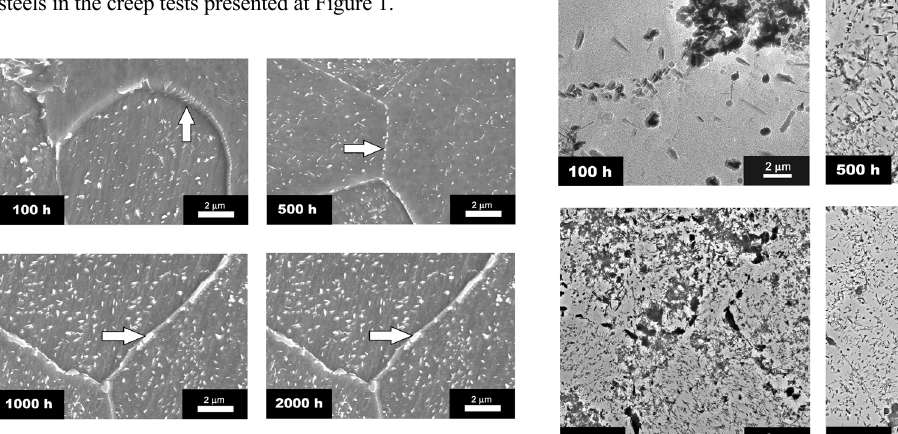
Figure 4: Ferritic-pearlitic steel scanning electron micrographs at 600°C and 100, 500, 1000 and 2000 h of aging. The arrows indicate the carbides coarsening effect.